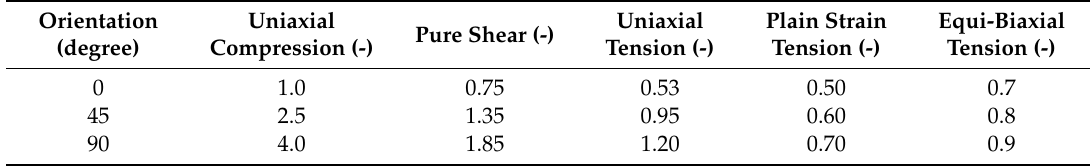
Table 2. Parameters for the failure criteria model.